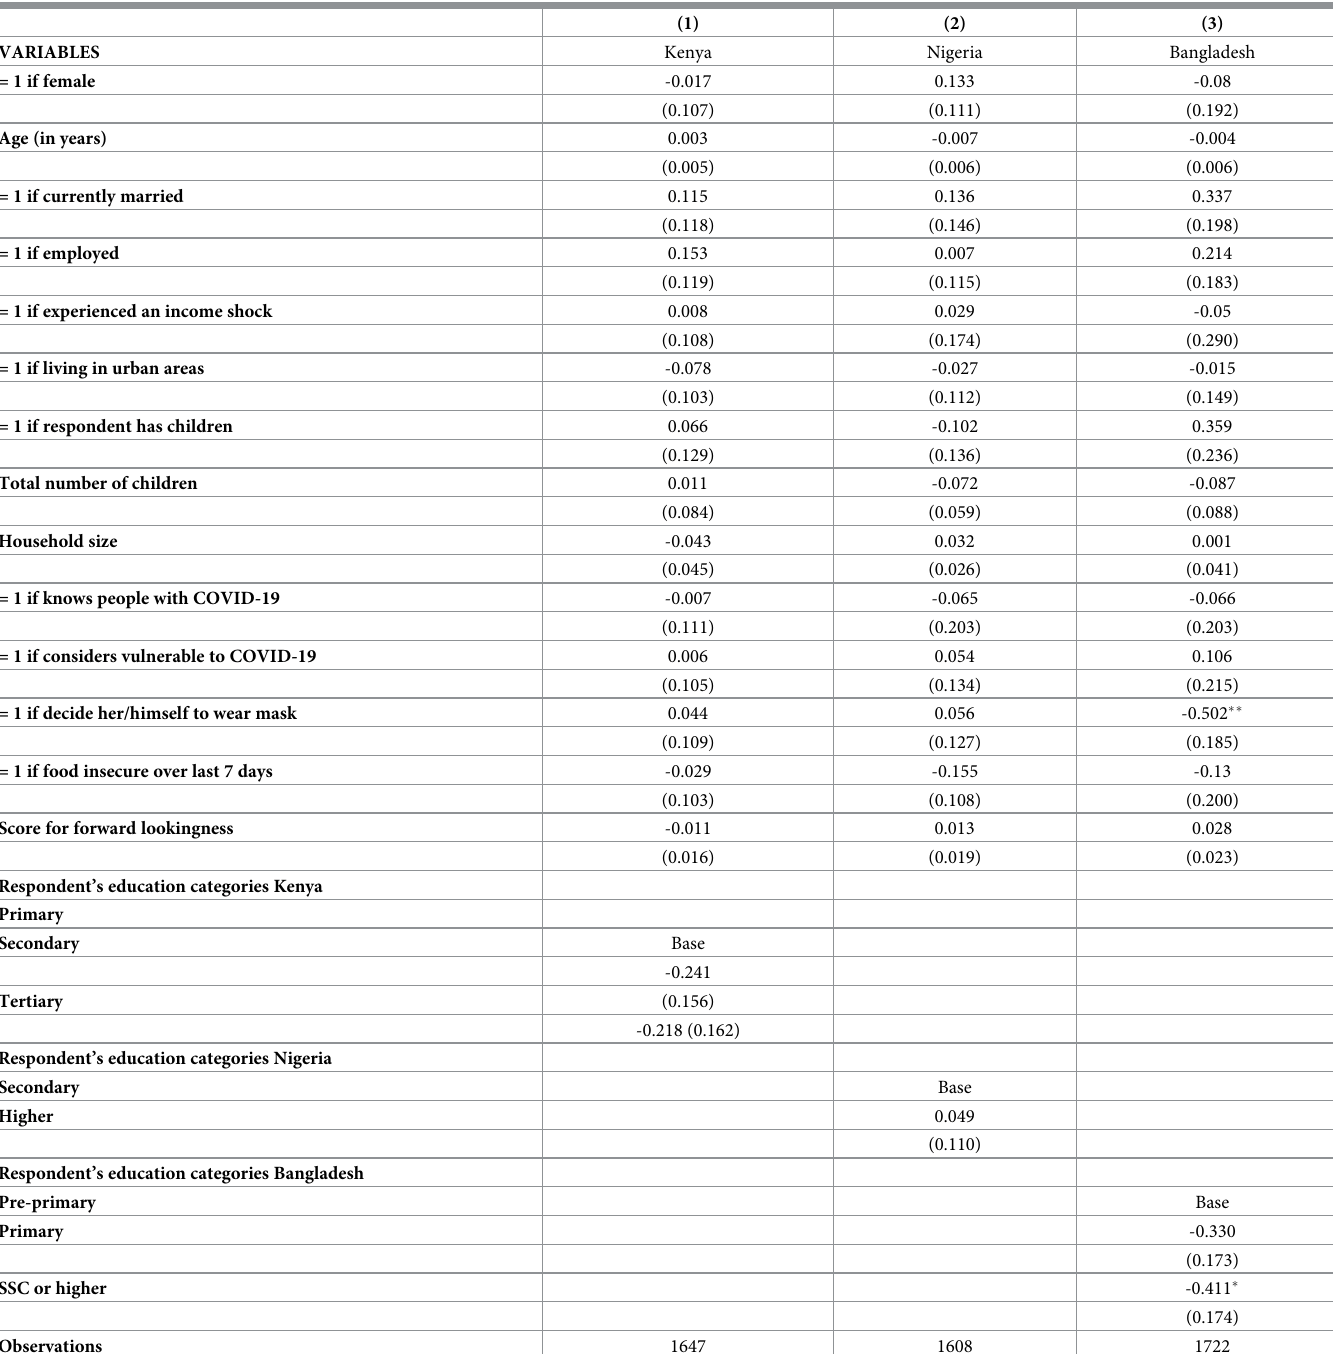
Table 2. Estimates of differences in elicited facemask wearing by socioeconomic and demographic determinants in all 3